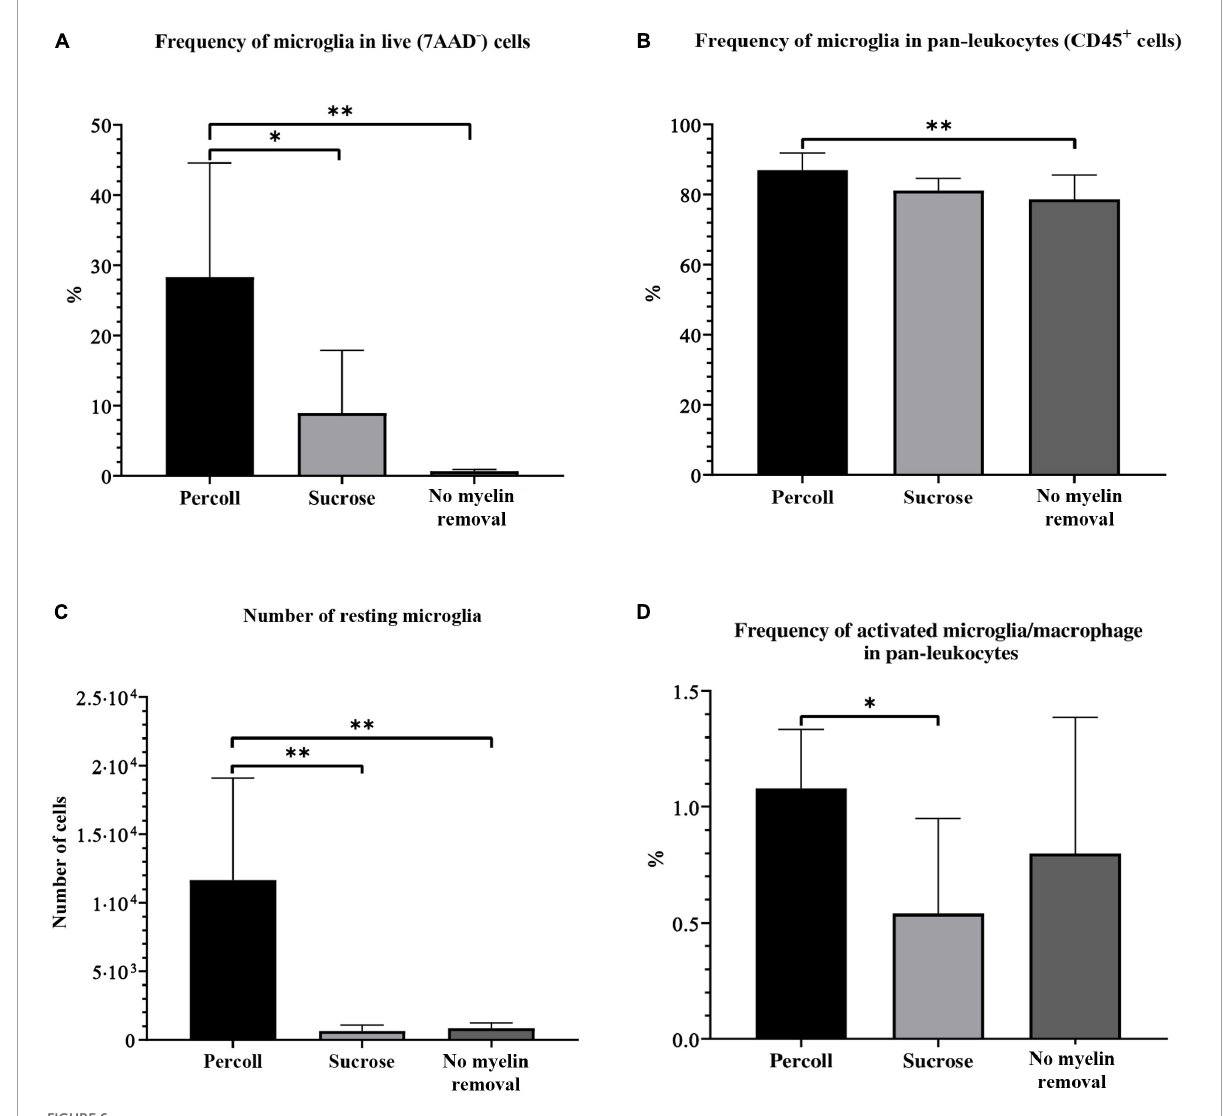
FIGURE6 The percentage of resting microglia in the live-cell population (A) , pan-leukocyte population (B) , absolute number of resting microglia (C) , and percentage of activated microglia and macrophages (D) on flow cytometry obtained by different myelin removal methods. ∗ P < 0.05; ∗∗ P < 0.01. N (mice per group) =